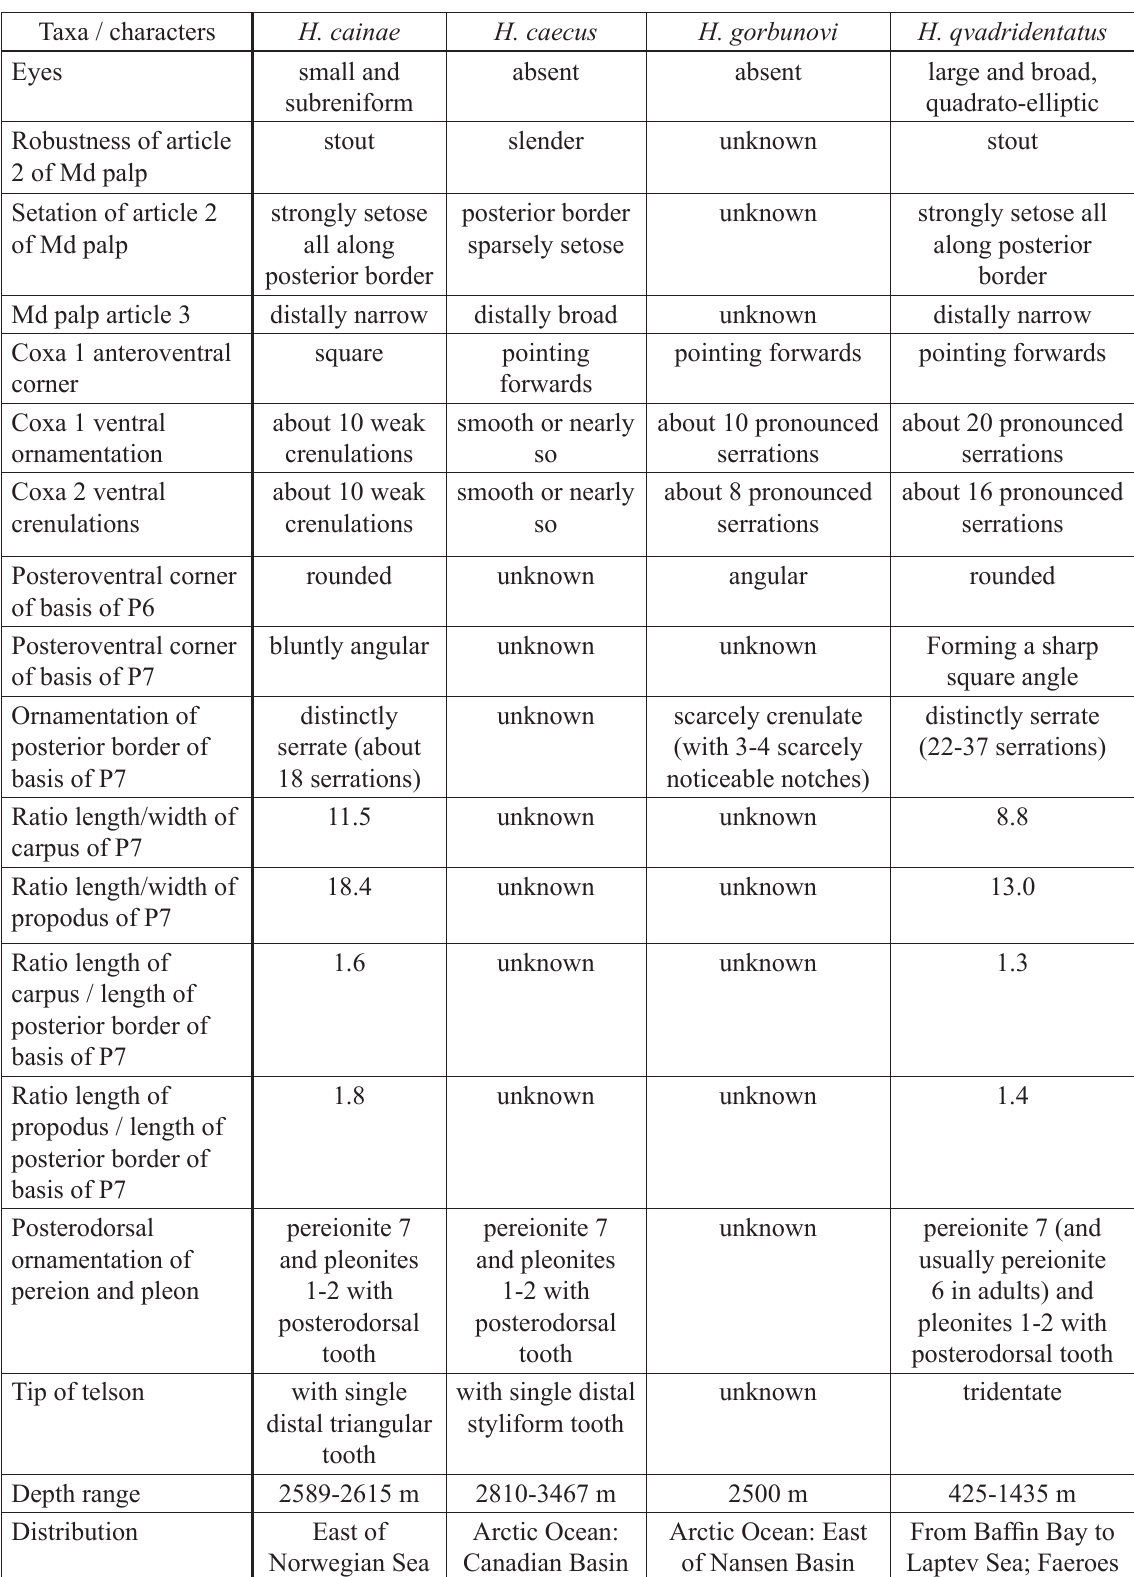
Table 1. Character states of Halirages species of the group qvadridentatus